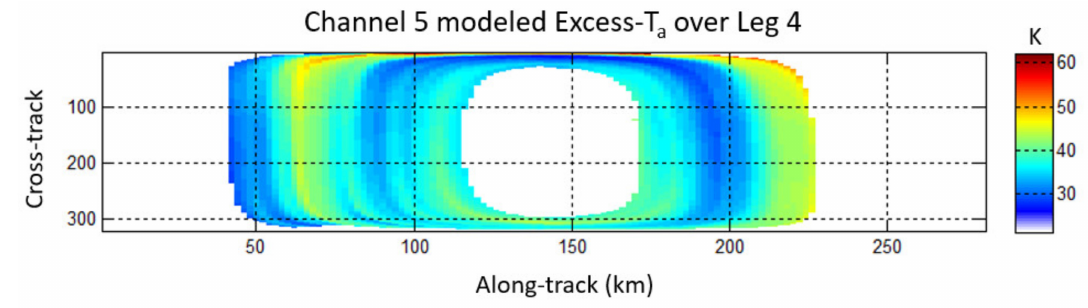
Figure 7. HIRAD Leg 4 modeled excess T a using interpolated SFMR WS and RR.